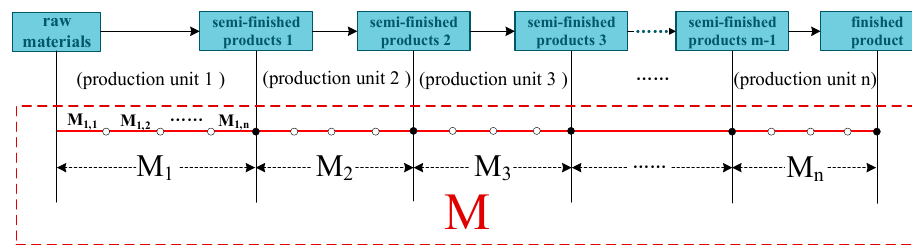
Figure 4. Product life-cycle stages.